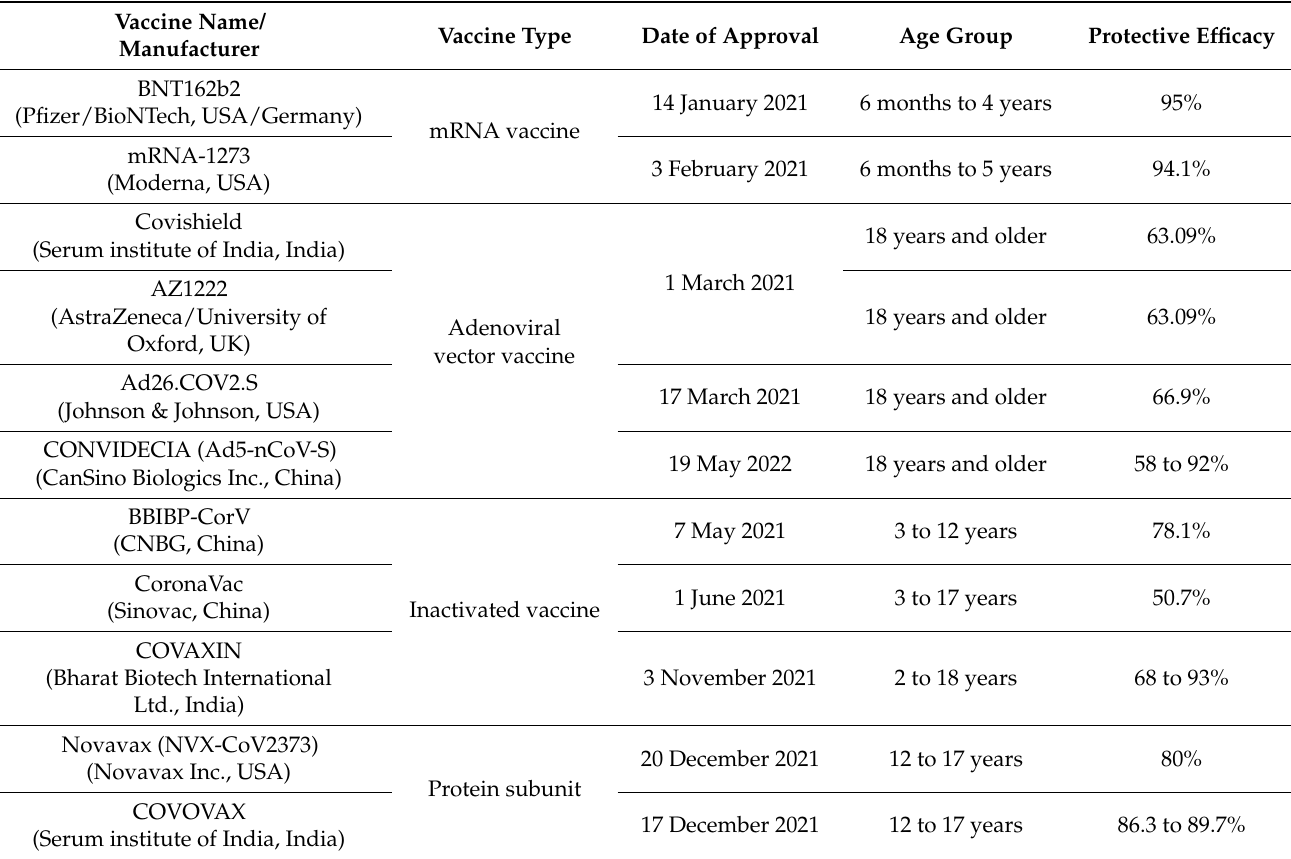
Table 2. List of COVID-19 vaccines granted EUA by the WHO, the FDA, and different health agencies